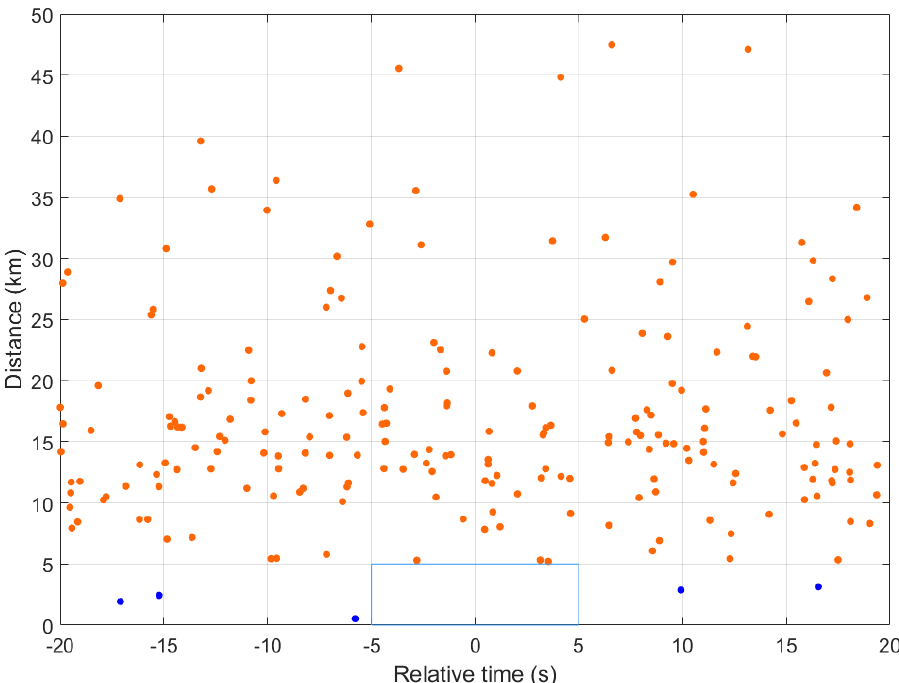
Figure 7. Distribution of natural lightning initiations in the distance relative to the triggered lightning point and time relative to the TLFs (within 20 s).